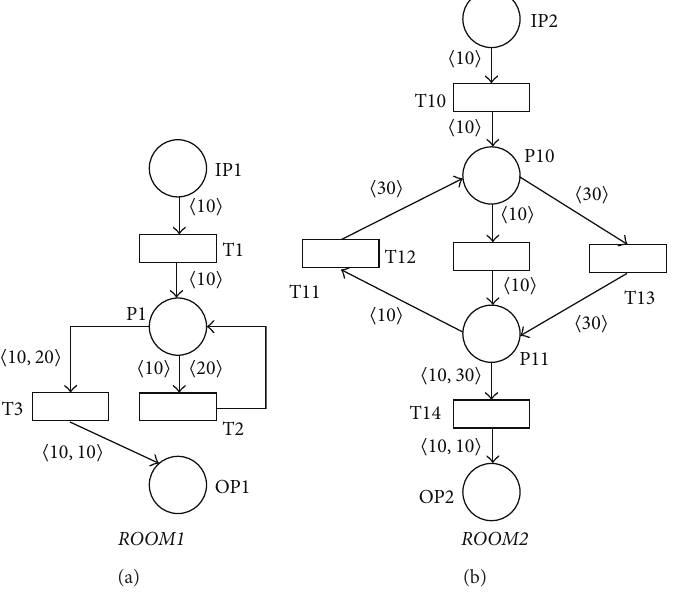
Figure 14: SNT process nets ROOM1 and